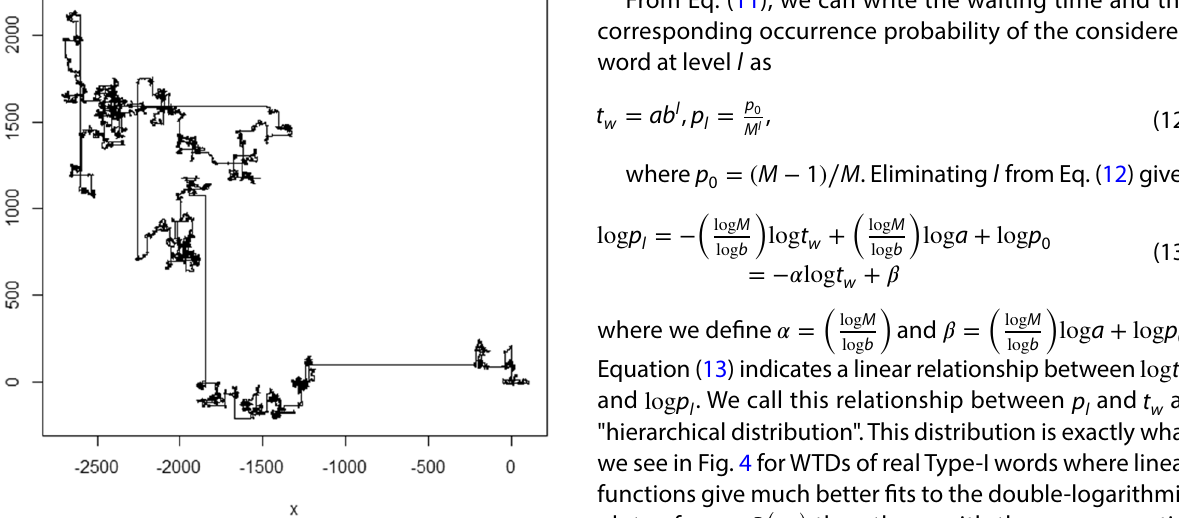
Fig. 7 Sample trajectory of a 2-dimensional Weiestrass random walk with 10,000 jumps. The trajectory was simulated using Eq. (10) with parameters a = 1.0 , b = 10.0 , and M = 30.0. The directions of jumps were restricted to ± x and ± y , and each direction was selected with equal probability